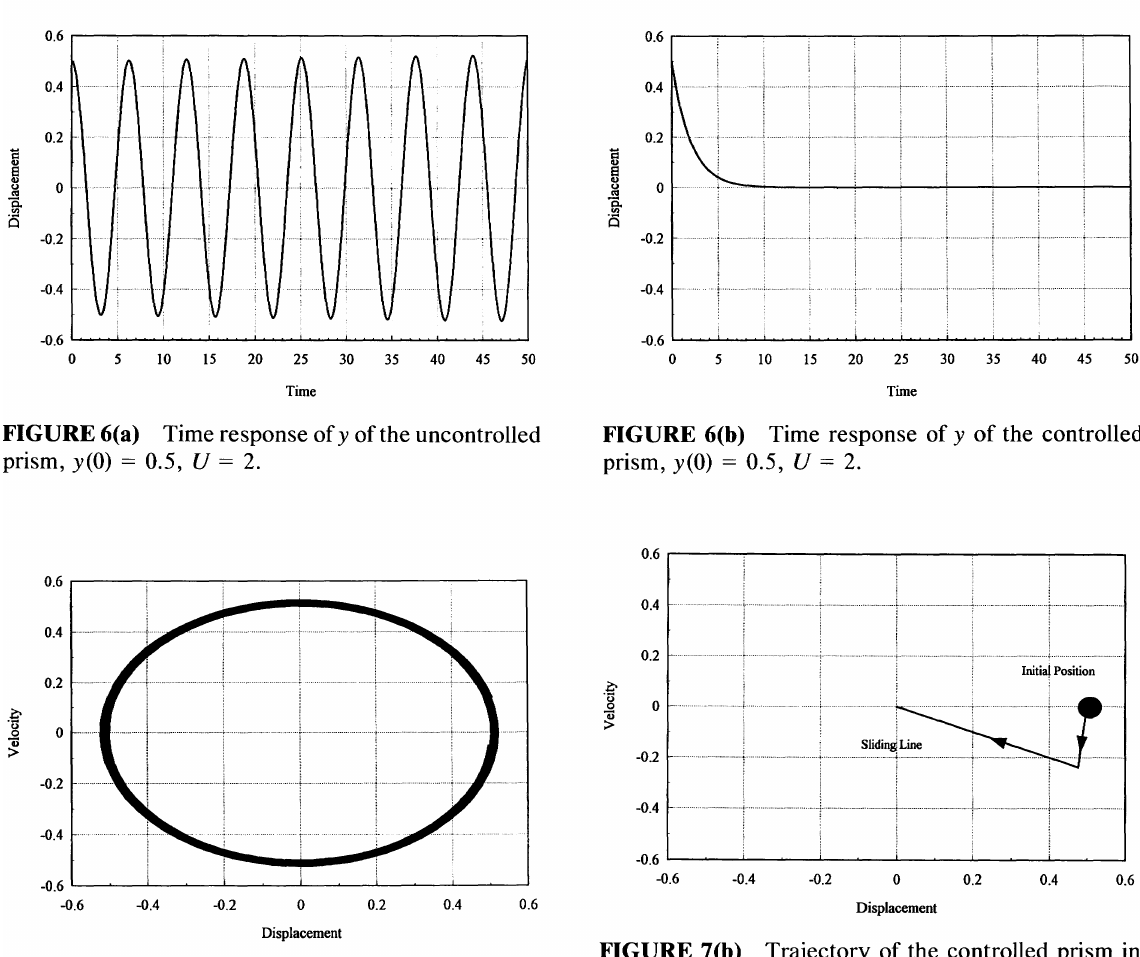
FIGURE 7(a) Trajectory of the uncontrolled prism in the phase plane y(O) = 0.5, U = 2.